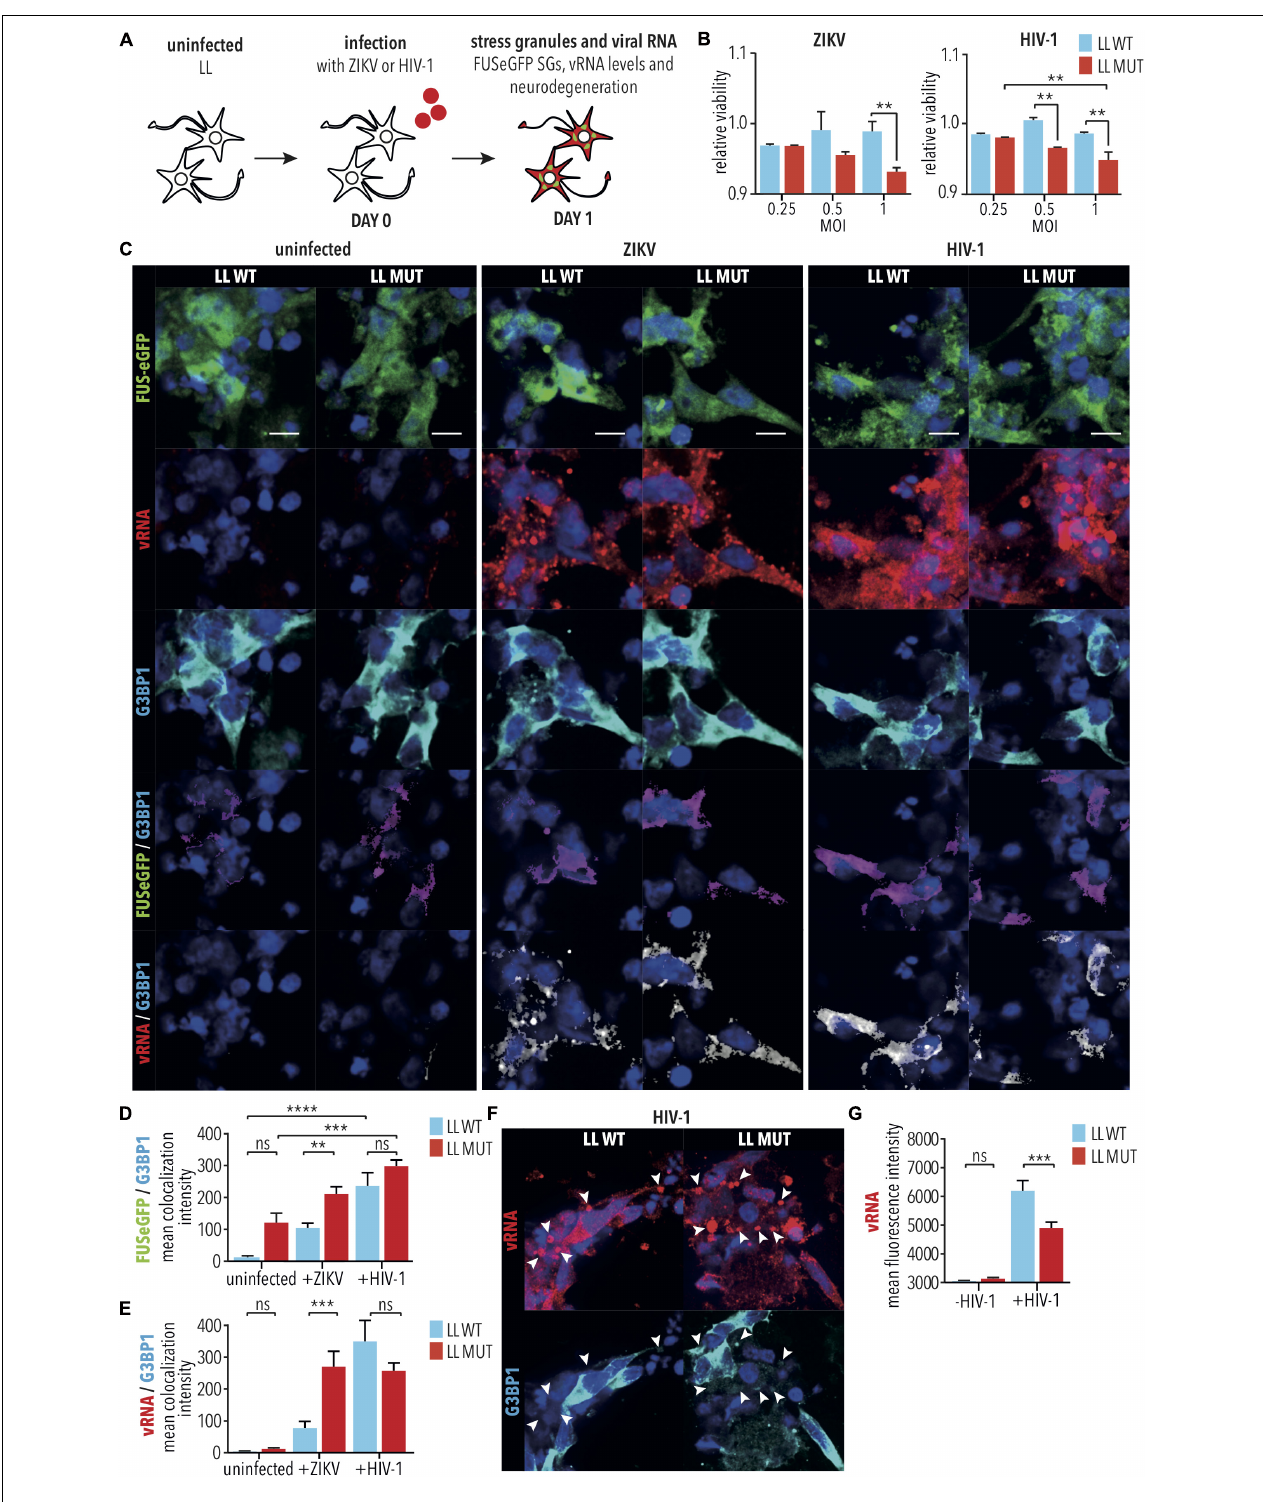
FIGURE 4 | Infection of iPSC-derived spinal neurons with HIV-1 and ZIKV. (A) Diagram illustrating HIV-1 or ZIKV infection of iPSC-derived spinal neurons with either WT FUS (LL WT) or FUS-P525L (LL MUT). (B) MTT assay was used to quantify viability of spinal neurons 1 day following infection under the indicated conditions. ∗∗ indicates p < 0.01 according to 2way ANOVA, Tukey post-test for multiple comparisons. n = 3. (C) Spinal neurons treated as indicated followed by imaging for vRNA as well as SG marker G3BP1. Scale bar = 5 µ m. (D,E) Co-localization analyses between (D) G3BP1 and FUS, (E) G3BP1 and vRNA following infection of